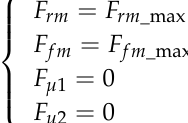
Figure 8. Front and rear axle braking force distribution curve.